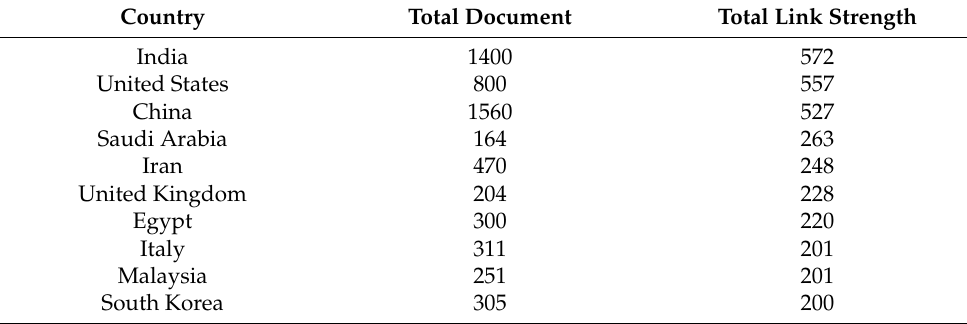
Table 5. Top 10 countries for author